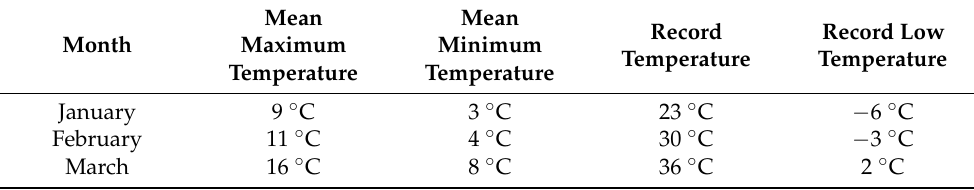
Table 1. Local winter climate information.